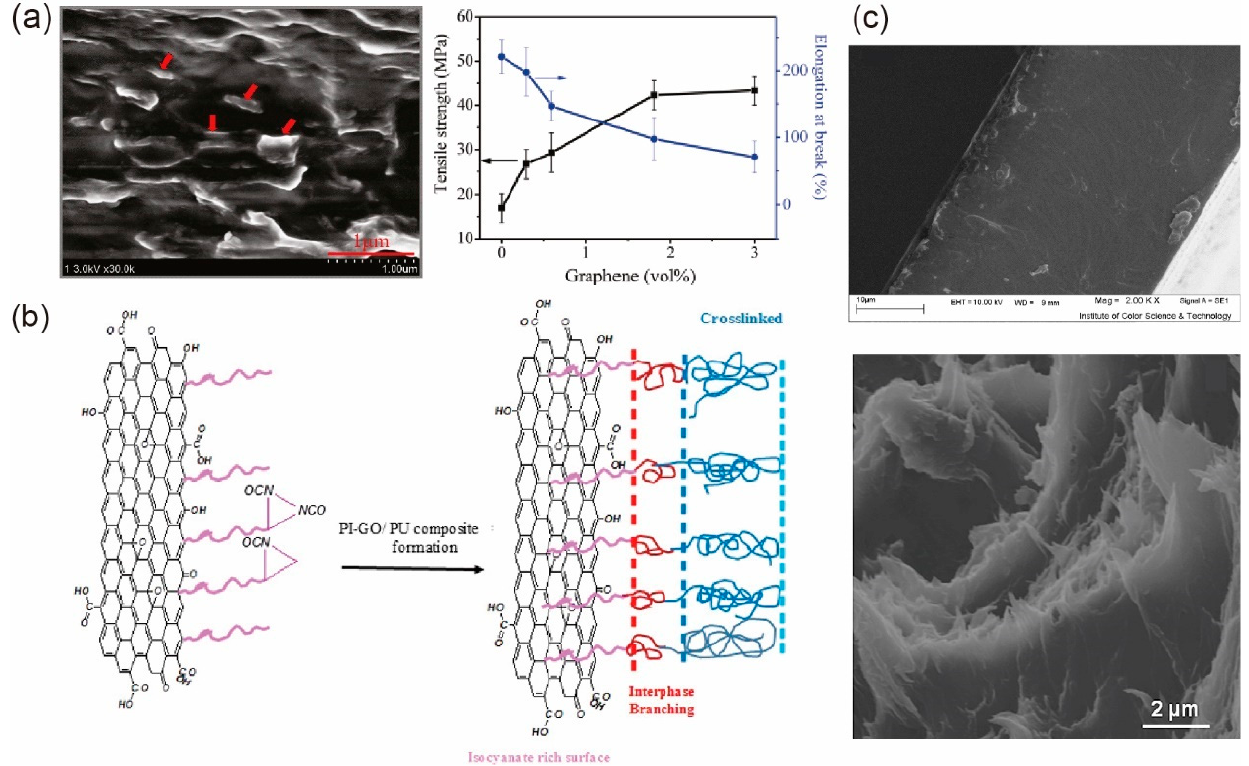
Figure 14. Graphene/polymer nanocomposites with graphene sheets dispersed in polymers. ( a ) Graphene sheets dispersed near randomly in polymers, enhanced strength and decreased break elongation. Reprinted with permission from [180]. ( b ) Introducing interfacial crosslinks (covalent bonds here) between graphene sheets and polymers brings out overall enhanced mechanical properties. Reprinted with permission from [43]. ( c ) Fractured surface of nanocomposites with covalent ( top ) and non ‐ covalent ( bottom ) functionalized graphene sheets. Reprinted with permission from [43,183].